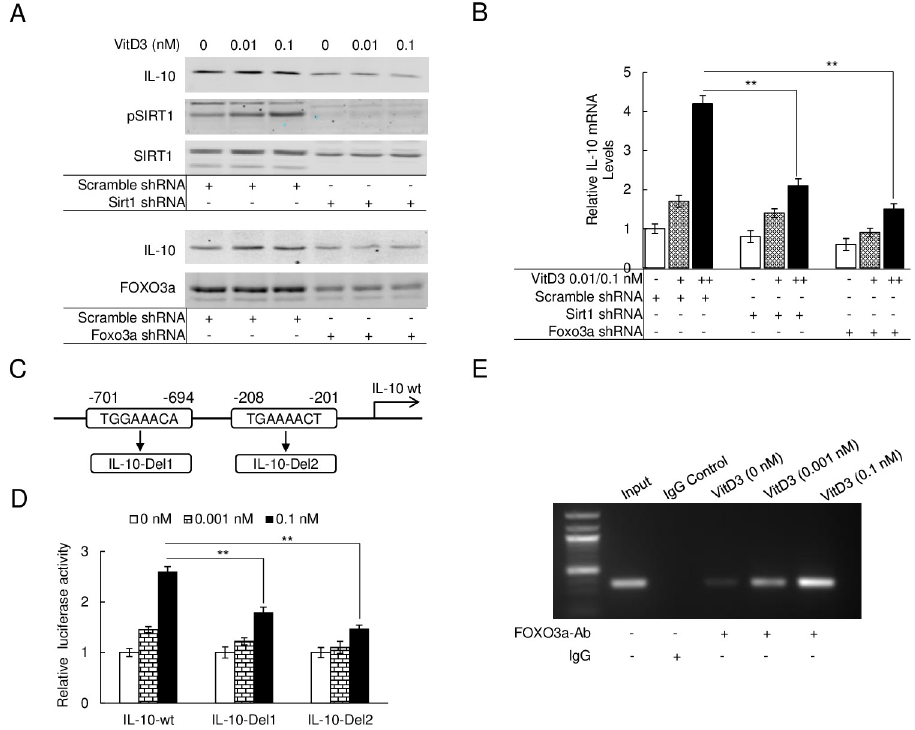
Fig 5. SIRT1/FOXO3a complex directly interacts with the IL-10 promoter region to induce its expression. (A) Immunoblot of IL-10 expression levels treated with VitD3 in SIRT1 knocking down HAECs (upper) or FOXO3a knocking down HAECs (bottom). Scramble shRNA transfected as control. (B) qPCR to quantify the mRNA levels of IL-10 on the VitD3 treated SIRT1 knocking down HAECs or FOXO3a knocking down HAECs ( �� p < 0.01, n = 3). (C) Genomic analysis of the promoter region and two traditional FOXO3a binding domains were acquired on -701 to -694 (TGGAAACA) and -208 to -201 (TGAAAACT). Gene modification to delete either of these two fragments and named as IL-10-Del1 or IL-10-Del2. (D) Luciferase reporter assay performed with IL-10-wt, IL-10-Del1 or IL-10-Del2 under VitD3 treatment ( �� p < 0.01, n = 3). (E) CHIP assay performed with the FOXO3a antibody under VitD3 treatment of HAECs.